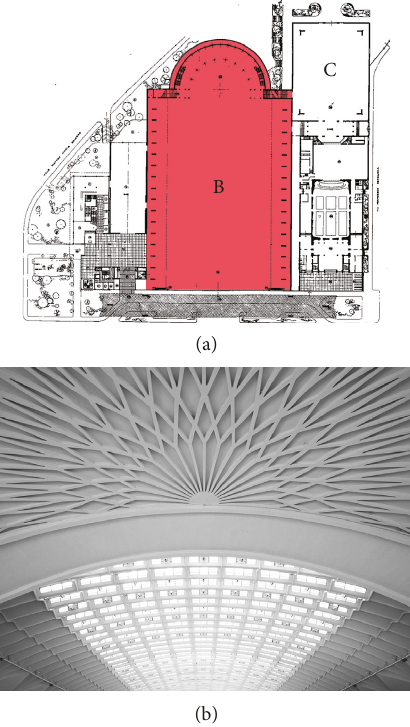
Figure 2: (a) Turin Exhibition Centre plan: the large hall with the semicircular apse is Hall B built in 1948 B [33]. (b) An interior of Hall B showing the detail of joint between the ribbed half-dome and the undulated vault.